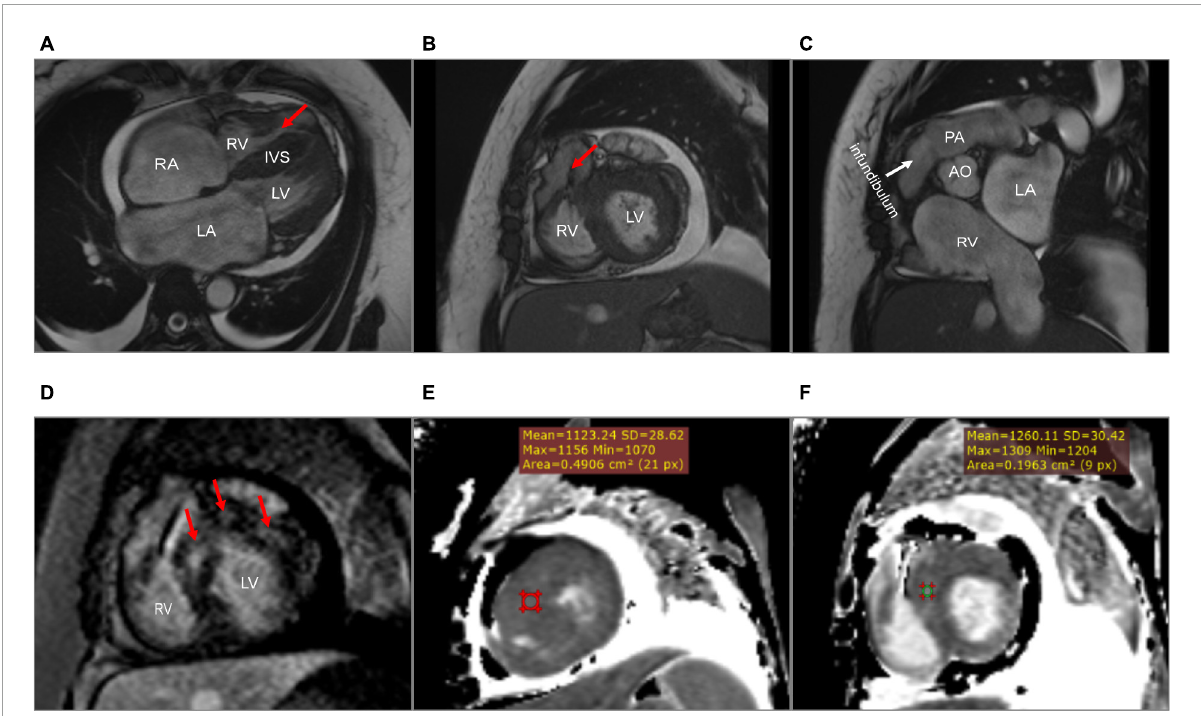
FIGURE3 Cardiac magnetic resonance. (A) A dumbbell-shaped right ventricle indicated right ventricular outflow tract obstruction (the red arrow). (B) A flow void sign at the right ventricular outflow tract (the red arrow). (C) No stenosis of infundibulum, pulmonary valve, and pulmonary artery. (D) Scattered patchy late gadolinium enhancement within the left ventricular myocardium (red arrows), particularly in the left ventricular anterior wall and the interventricular septum. (E,F) The native T1 mapping revealed the markedly increased T1 value at the basal interventricular septum from 1,123 to 1,260 ms. LA, left atrium; RA, right atrium; LV, left ventricle; RV, right ventricle; IVS, interventricular septum; PA, pulmonary artery; AO, aorta.